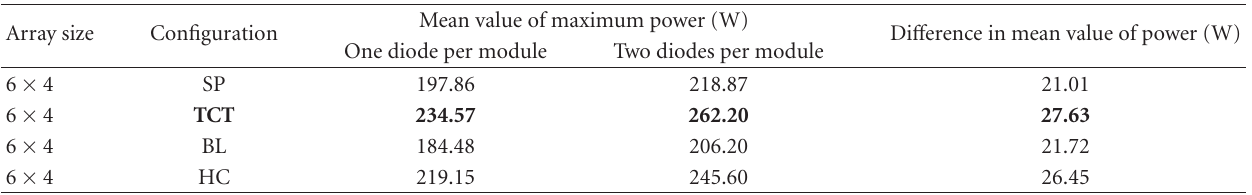
Table 5: Comparison between mean value of the maximum power for 6 × 4 configurations with one bypass diode and two bypass diodes per module under random shading patterns.